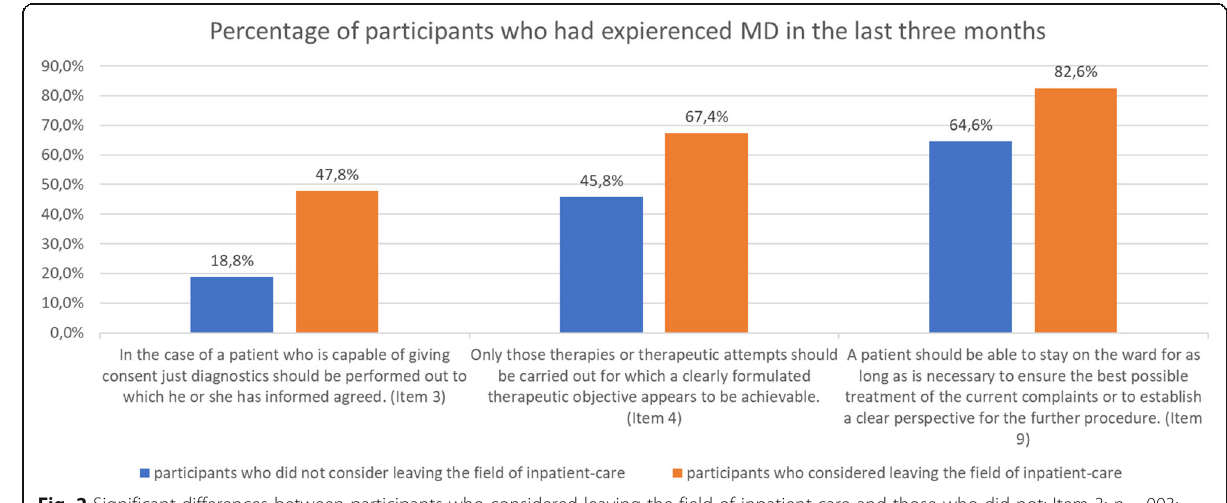
Fig. 2 Significant differences between participants who considered leaving the field of inpatient-care and those who did not; Item 3: p = .003; Item 4: p = .036; Item 9: p =